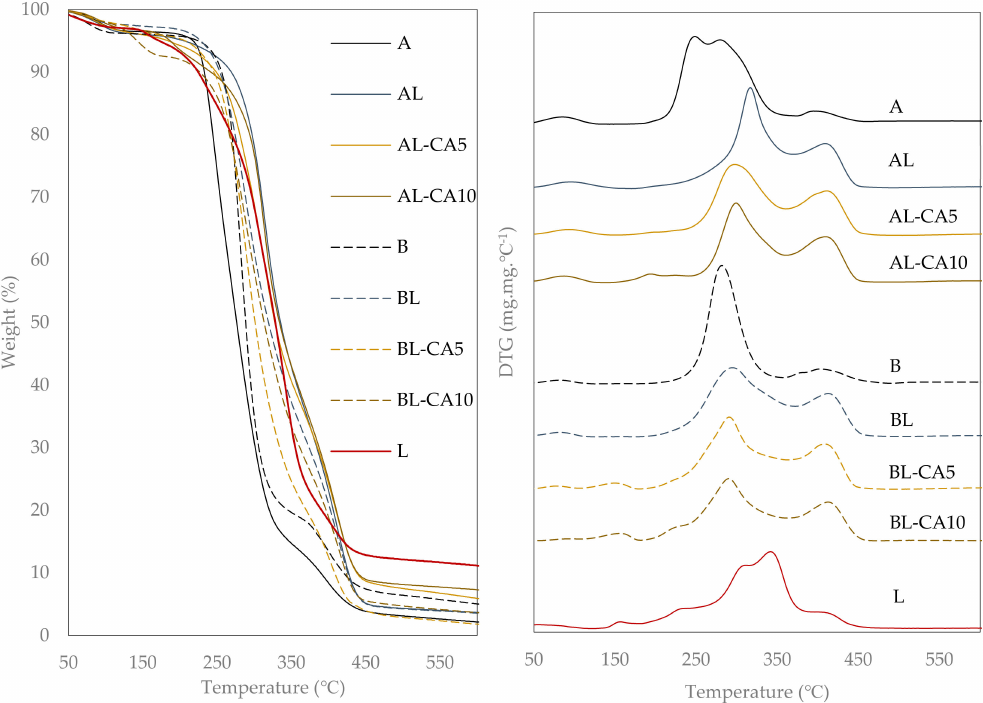
Figure 4. Thermogravimetric analysis (TGA) (left) and DTGA (right) curves of the PVA films (A and B) without and with carvacrol (5 or 10 g / 100 g PVA) previously encapsulated in lecithin liposomes